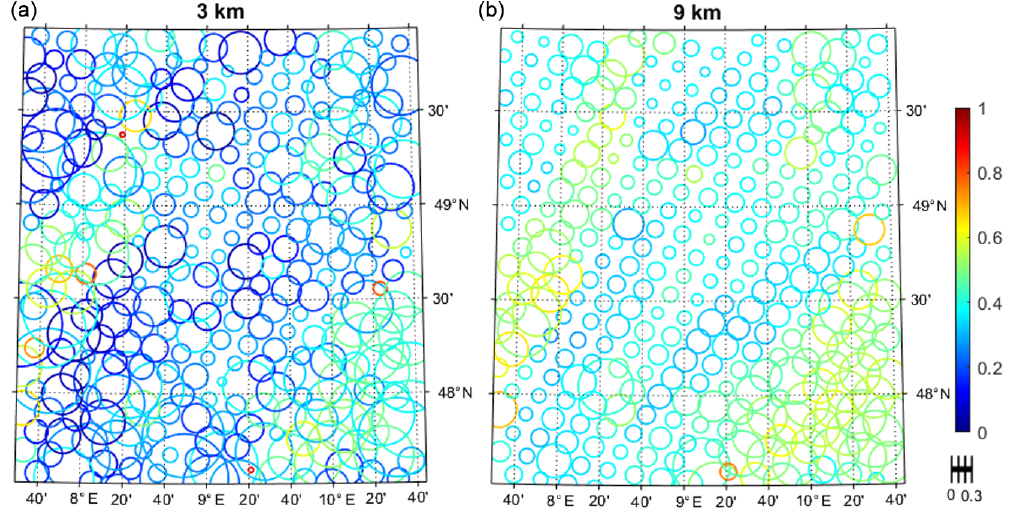
Figure 10. The spatial distribution of the soil moisture sampling confidence to achieve the 0.04cm 3 cm − 3 accuracy requirement by sampling 3km (a) and 9km footprints (b) with three and five sites, respectively (see the scale below the color bar). The colors show the minimum confidence level throughout the year 2015 for every footprint. The scale is soil moisture accuracy that can be